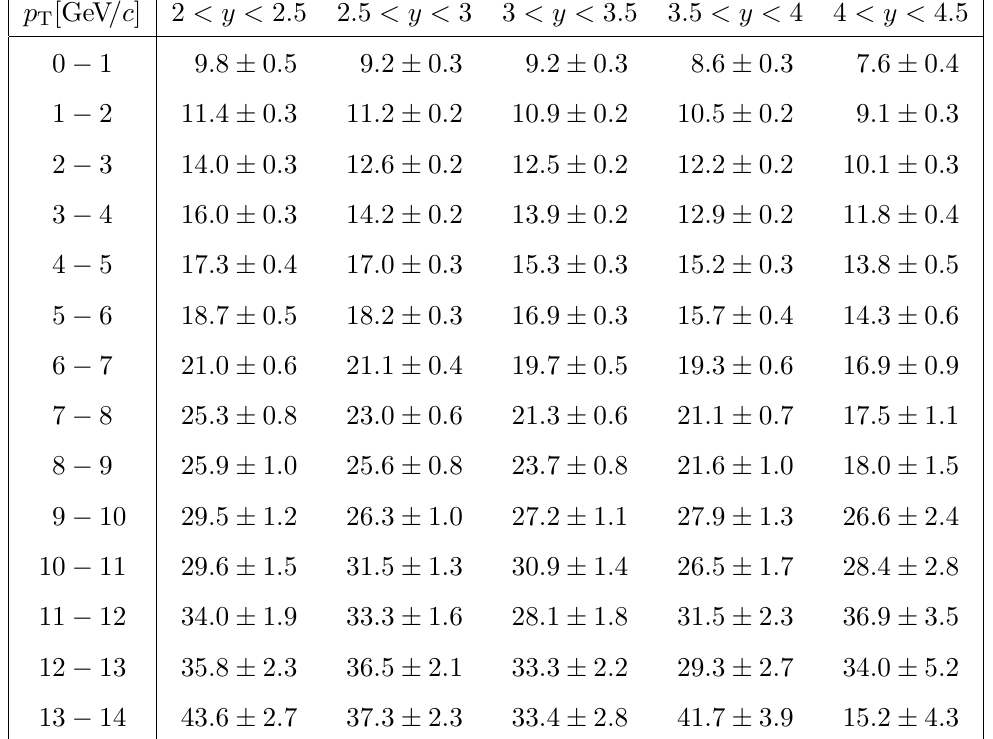
Table 6 . The fraction of J= -from- b mesons (in %) in bins of the J= transverse momentum and rapidity. The uncertainties are statistical only. The systematic uncertainties are negligible.